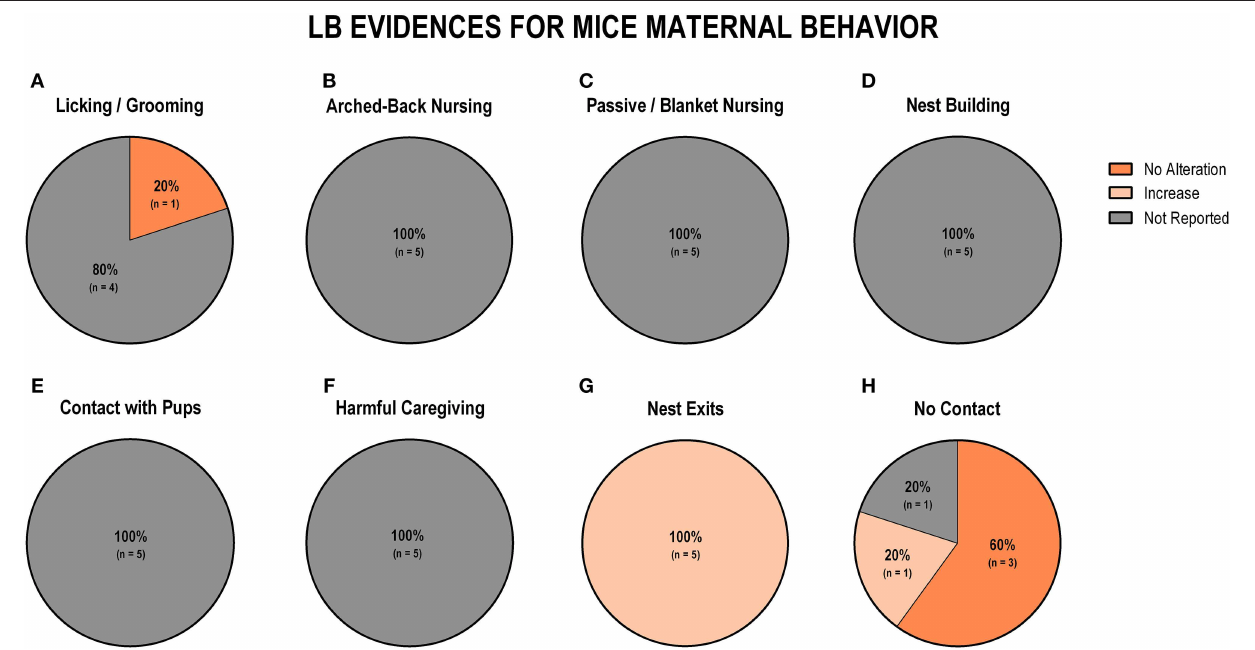
FIGURE 8 | Percentage of behavior findings from LB mice studies. Licking and grooming behavior (A) . Arched-back nursing behavior (B) . Passive and blanket nursing behavior (C) . Nest building behavior (D) . Contact with pups behavior (E) . Harmful caregiving behavior (F) . Nest exits behavior (G) . No contact behavior (H) .